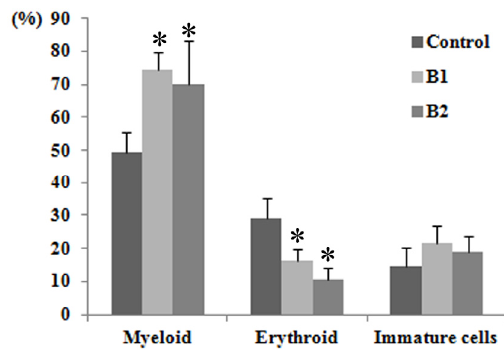
Figure 2. Bone marrow smear examination in male C3H/He mice following 7 days of benzene exposure. * significant difference compared with control group ( p < 0.05).